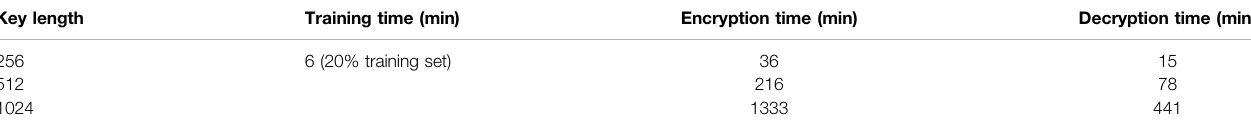
TABLE 5 | Time analysis of the homomorphic encryption process. For training time, we record the average time for training one epoch with 20% data. Key length